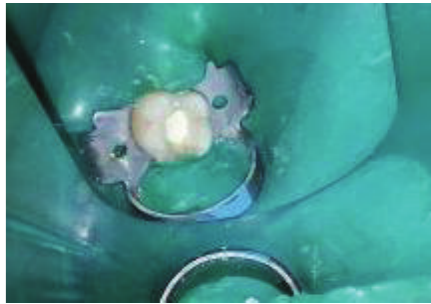
Figure 6: Placement of Biodentine over PRF membrane.